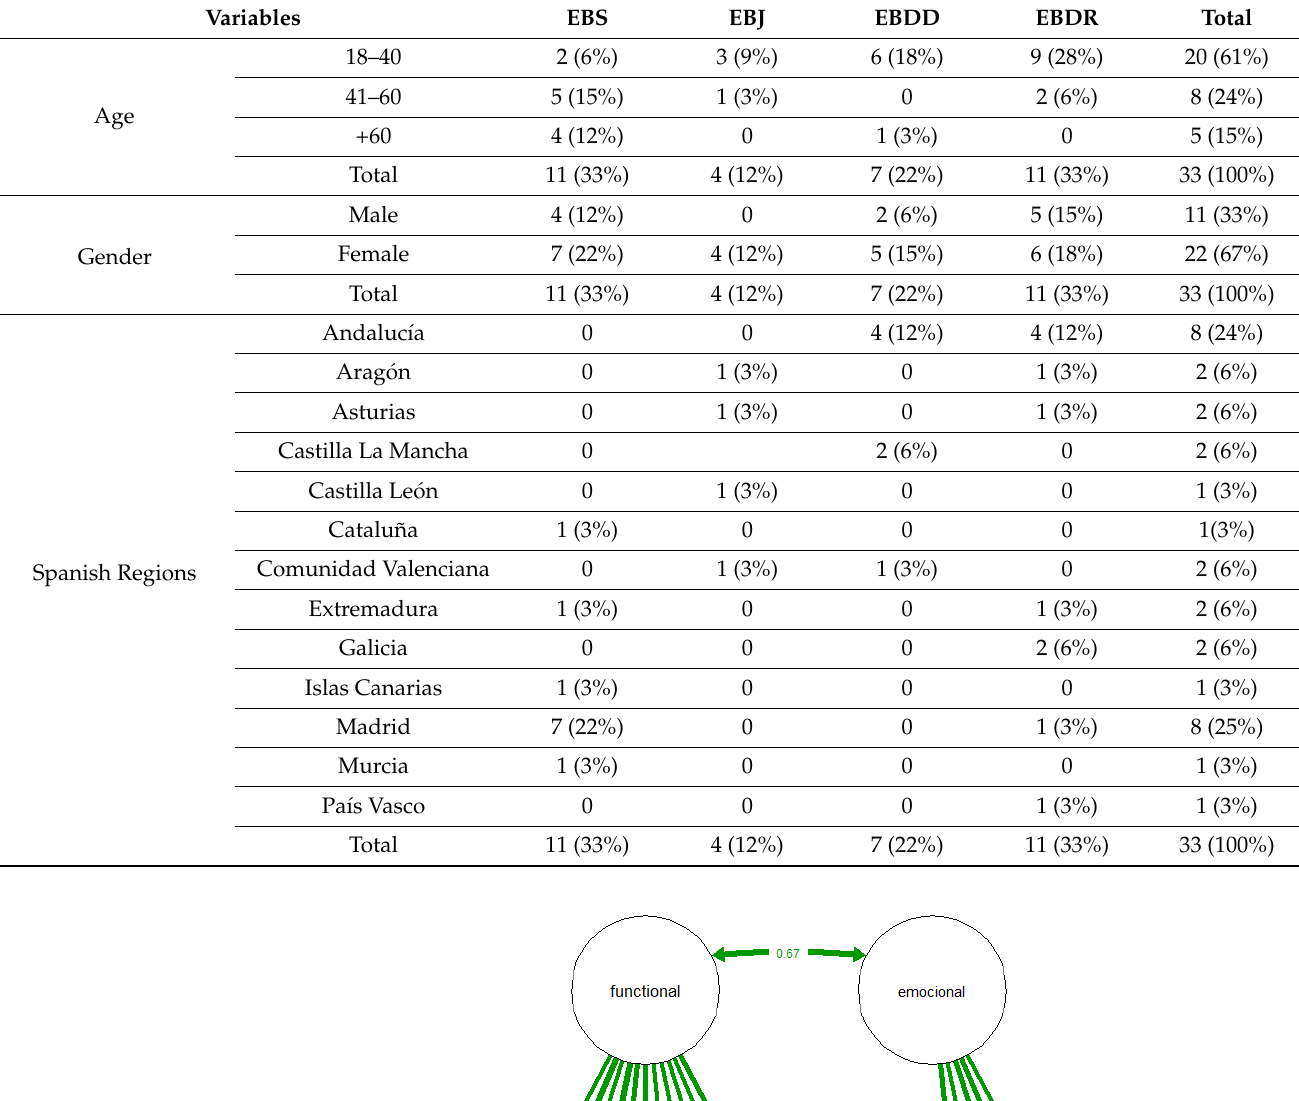
Table 1. Sociodemographic characteristics of the participants.